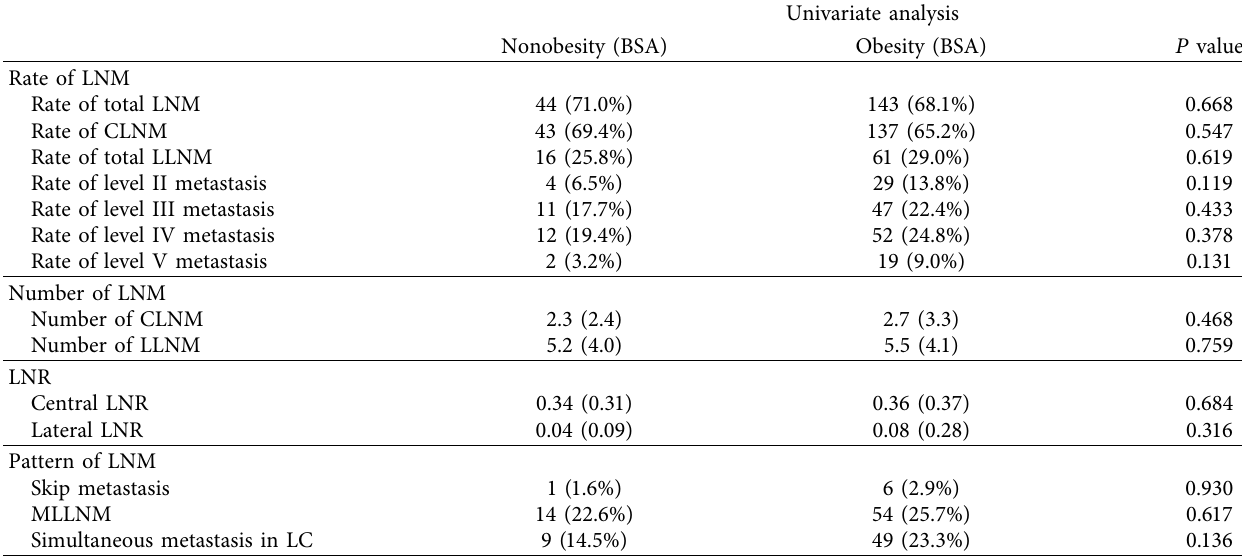
Table 5: Relationship between BSA and diferent regional lymph node involvement in